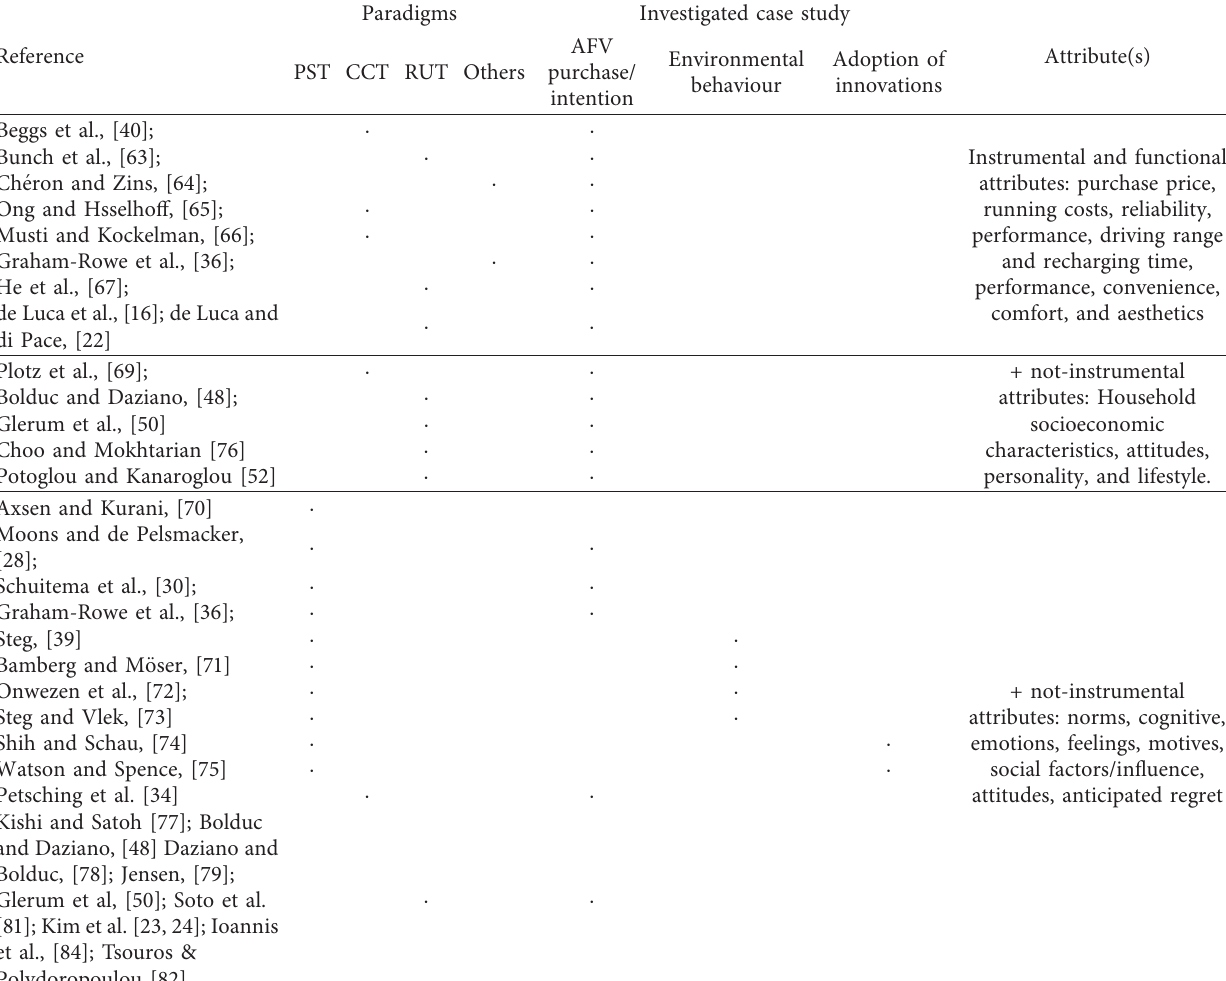
Table 1: Synoptic framework of the state of the